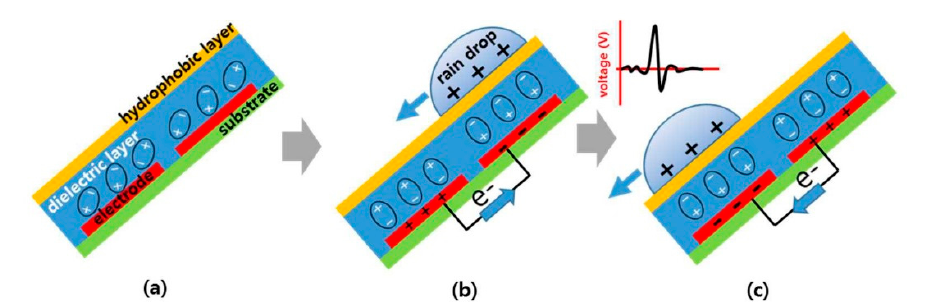
Figure 1. Fundamental operation principle of rain drop counting sensor using water motion active transducer (WMAT): ( a ) No contact between rain droplet and sensor; ( b ) Rain droplet was charged positively in contact with the negative charged PVP dielectric layer; ( c ) Rain droplet moved to the second electrode of sensor and the negative charges of the first electrode moved to the second electrode.